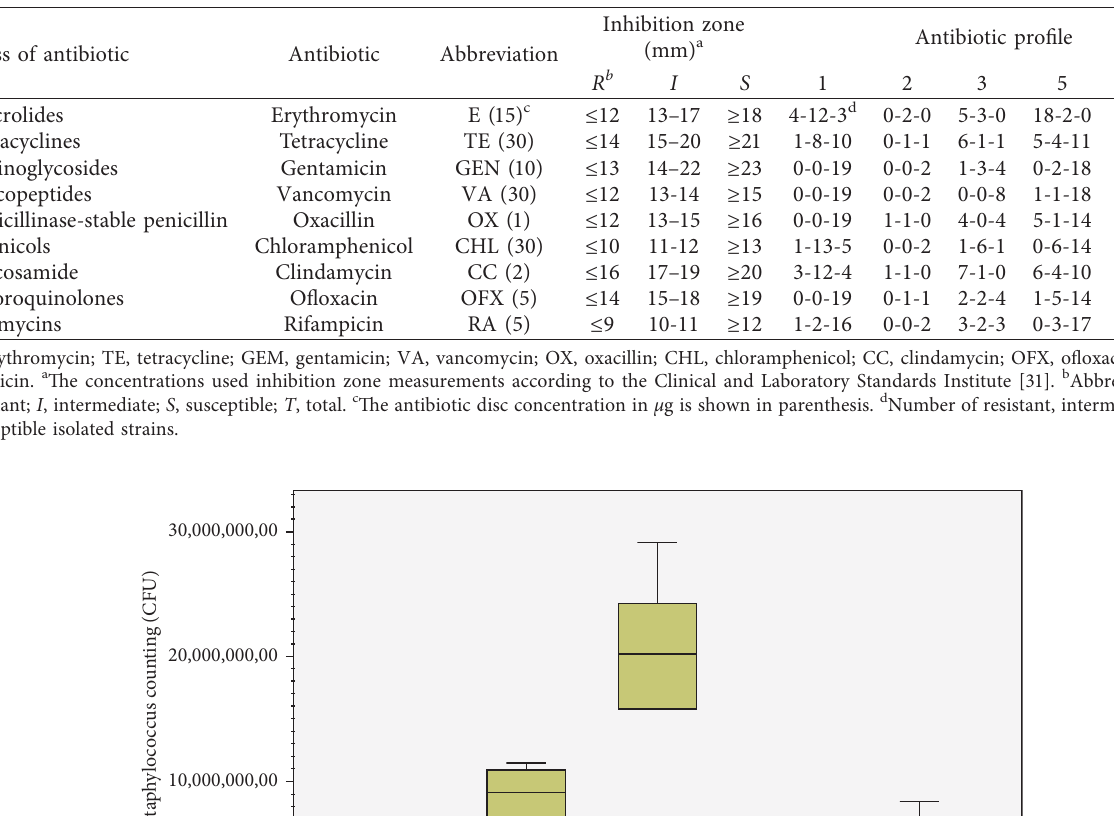
Table 1: Antibiotic resistance profiles of S. aureus isolates from five pasteurized cheese brands in